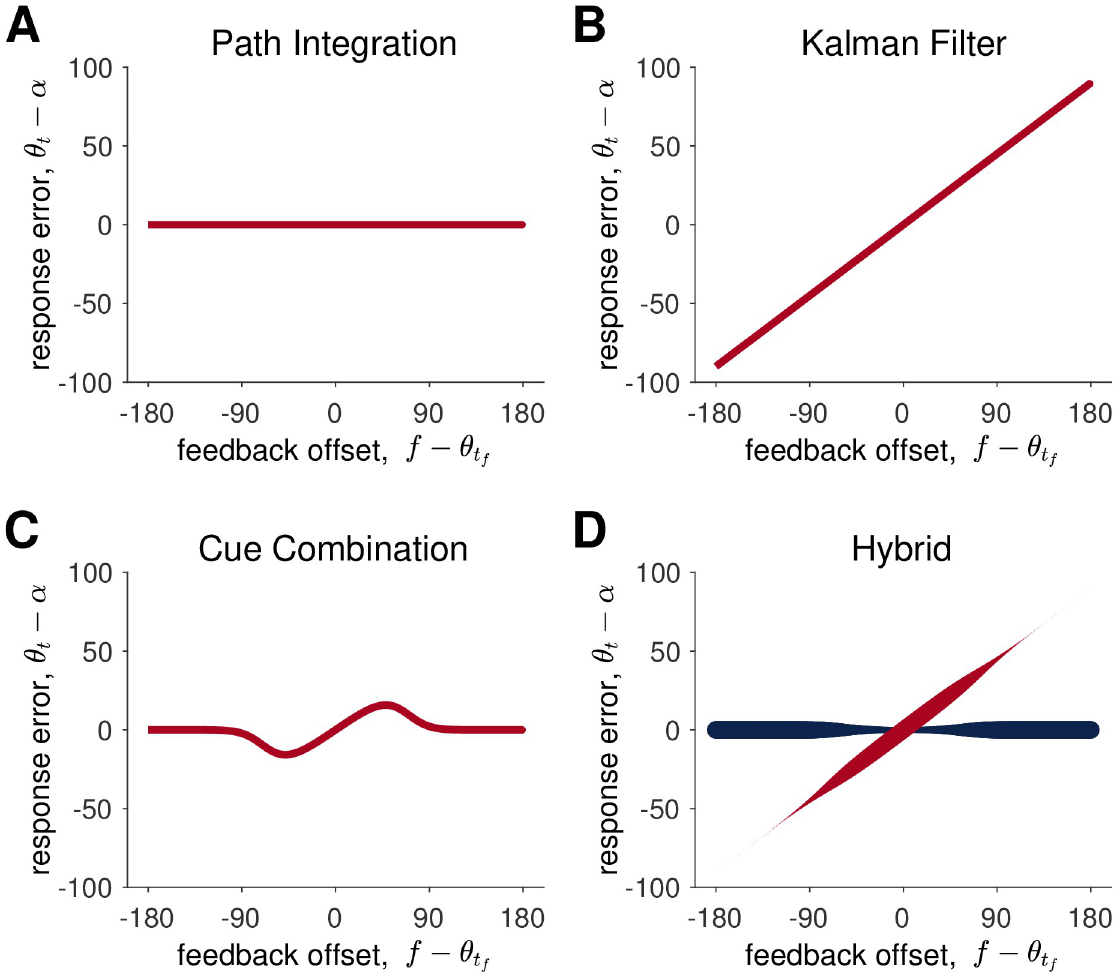
Fig 3. Model predictions for the Path Integration, Kalman Filter, Cue Combination, and Hybrid models. In (A-C) the red lines correspond to the mean of the response error predicted by the model. In (D) the two lines correspond to the mean response when the model assumes the feedback is true (red) and false (blue). The thickness of the red and blue lines in (D) corresponds to the probability that the model samples from a distribution with this mean, i.e. p true for red and 1 − p true = p false for